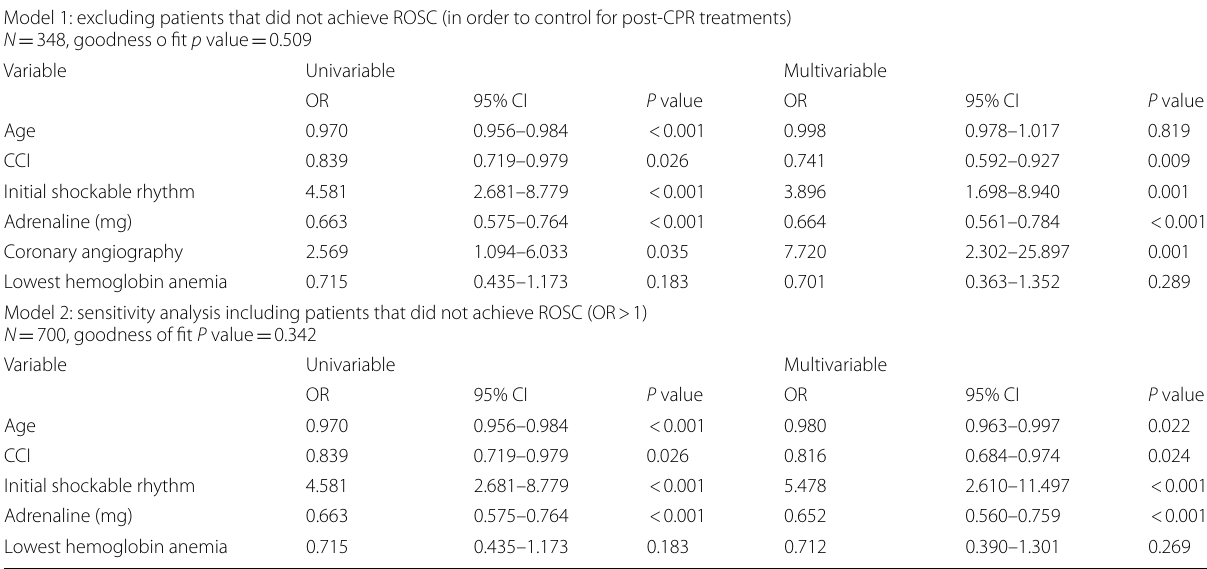
OR odds ratio, CI confidence interval, CCI Charlson comorbidity index